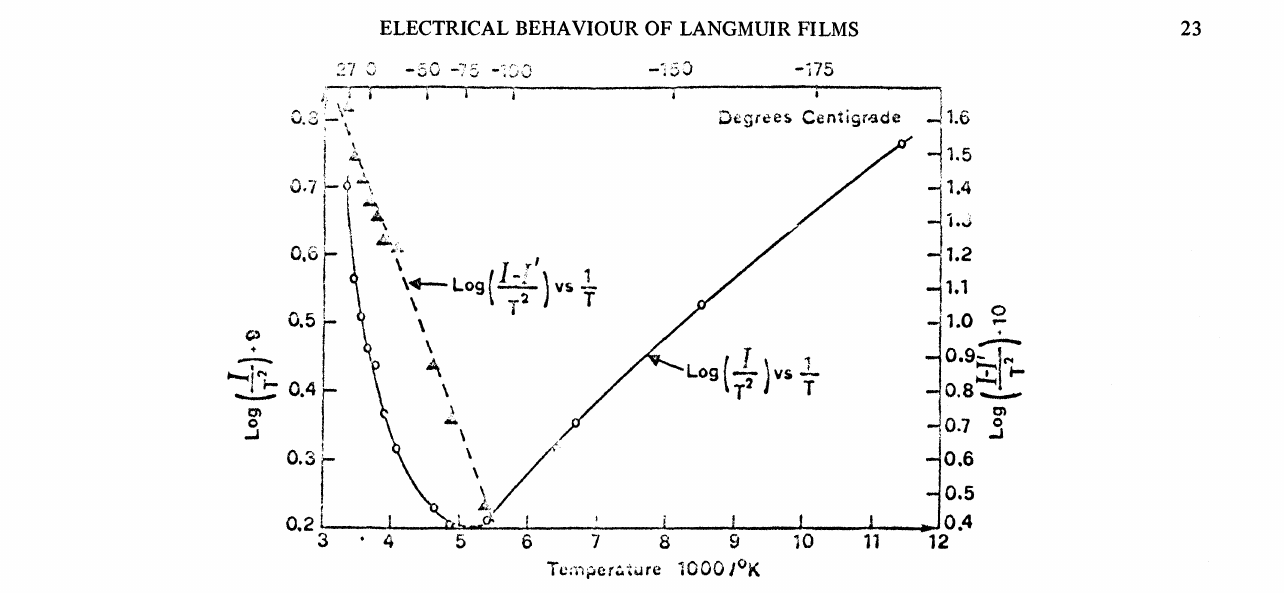
FIGURE 12 Plot of log (I/T 2) vs. (l/T) and log ((I-I’)/T 2) vs. (lIT) for 3 layer sandwich, where total current, I’ low temperature current in amperes and T absolute temperature. [After Handy and Scala* .]